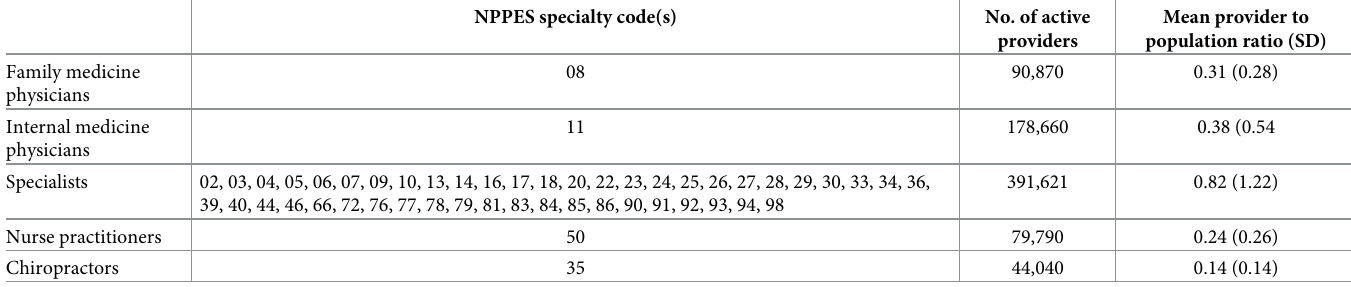
Table 1. Specialty codes used to identify providers, number of active U.S. providers, and mean provider to population